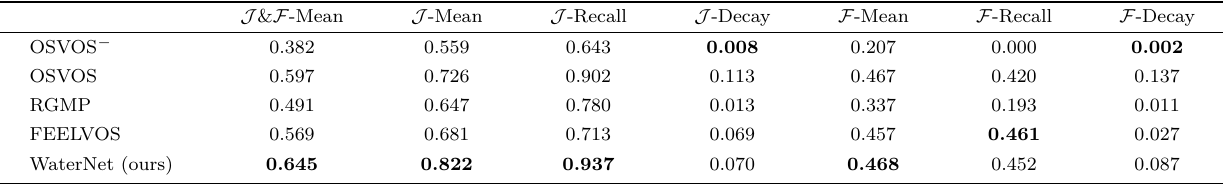
Table 1 Comparison of WaterNet with other state-of-the-art methods on WaterDataset . Region ( J ) calculates the intersection-over-union (IoU) of the estimated mask and the ground-truth mask. Boundary ( F ) evaluates the accuracy of boundaries. Mean is the average error. Recall measures the fraction of sequences scoring higher than a threshold. Decay measures how performance changes overtime. Mean and Recall are the two most important measures